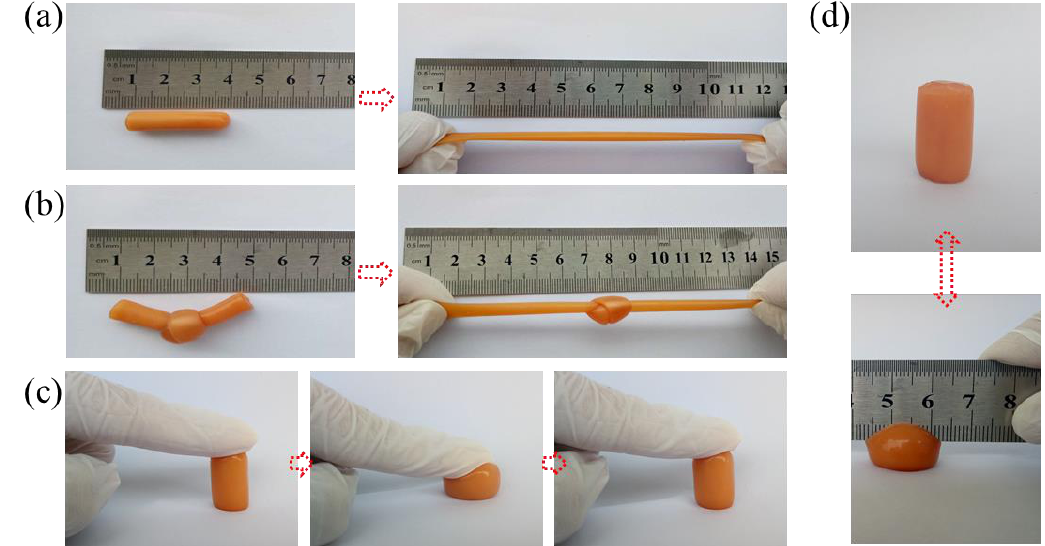
Figure 2. Photographs of P(AAc- co -Am)/PVA double network hydrogels (Gel-9) under different conditions demonstrating their excellent mechanical deformation and recoverability. The hydrogels showing their ability to withstand stretching ( a ), knotting ( b ), compression ( c , d ).